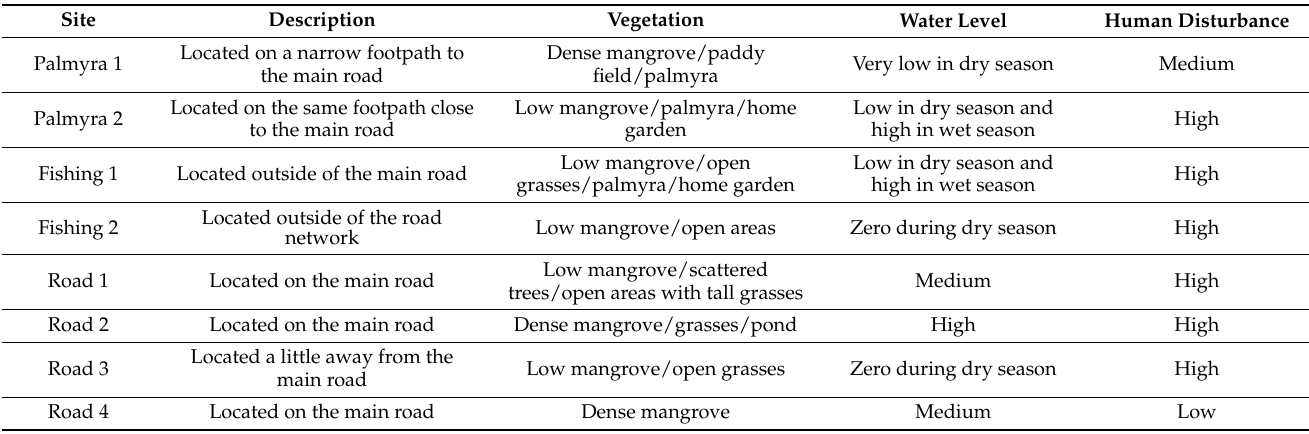
Table 1. Description of the sampling